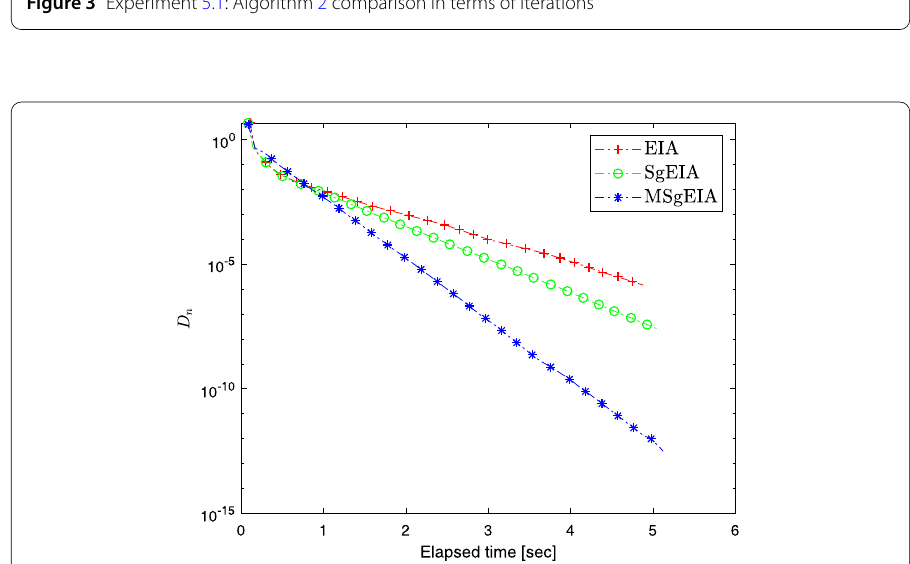
Figure 4 Experiment 5.1: Algorithm 2 comparison in terms of elapsed